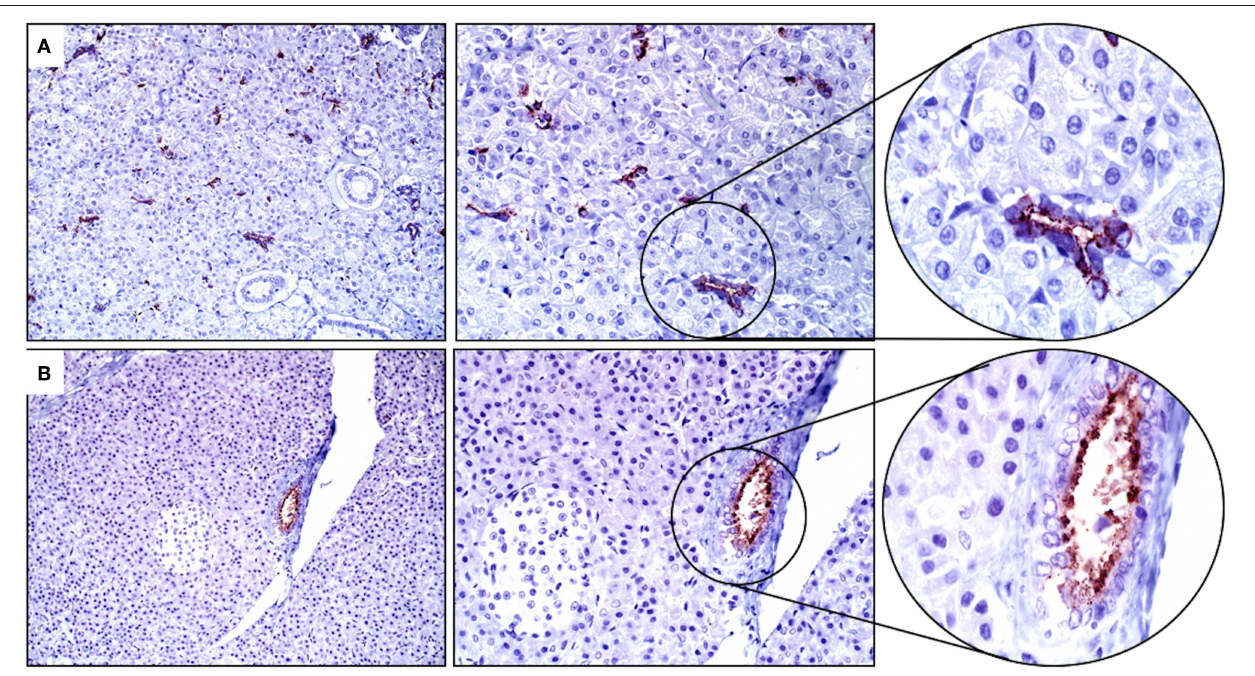
FIGURE 5 | Salivary gland and pancreas. (A) There is strong cytoplasmic staining in intercalated duct and serous Demilune cells of the salivary gland but not in striated duct cells. (B) Pancreatic ducts have moderate staining concentrated along the apical surface. Neither sialocytes nor exocrine pancreatic cells are positive for SALSA. Magnification as in Figure 2 .